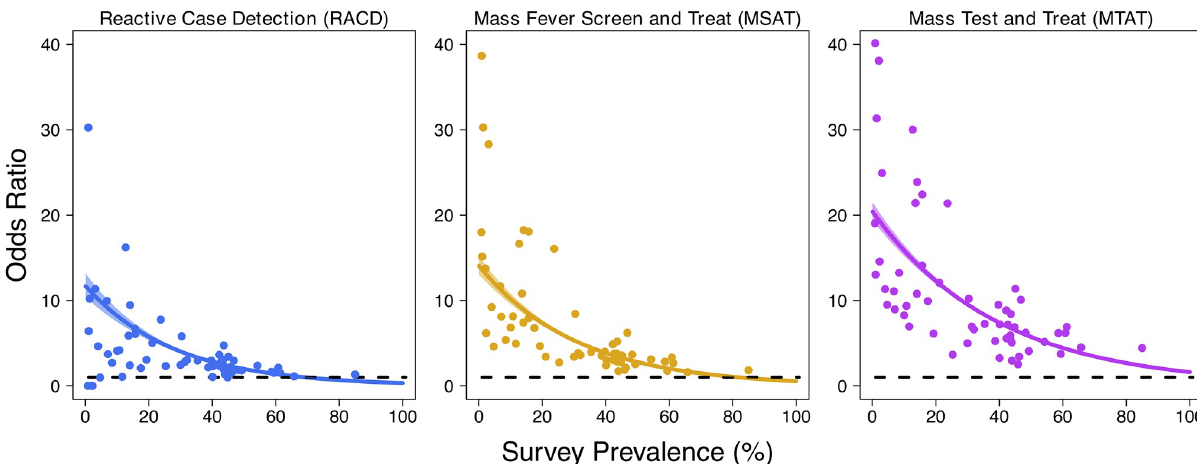
Fig 2. Malaria infection and the extent of household clustering according to detectability by different programmatic strategies. DHS data from 57 surveys and 23 countries detailing malaria infection status in children under 7 were collated, and the extent of infection clustering based on detectability by different programmatic strategies (RACD, MSAT or MTAT) was assessed. For each of these analyses, an individual was defined as residing in an index household if the household contained at least 1 other infection detectable through the programmatic strategy considered. The OR of being malaria positive in children who share a household with another child detectable through (A) RACD (clinical care seeking; population-level screening for infecton using routine diagnostics such as RDTs), (B) for the MSAT strategy (population-level recent fever screening), and (C) for the MTAT strategy (population-level screening for infecton using routine diagnostics such as RDTs) as compared to those who do not. Plots display the modelled OR (generated using a logistic-regression approach, coloured line) whilst points are the same ORs but calculated empirically for each survey. Pale shaded area represents the 95% CrI. CrI, credible interval; DHS, demographic health survey; MSAT, Mass Screen and Treat; MTAT, Mass Test and Treat; OR, odds ratio; RACD, Reactive Case Detection; RDT, rapid diagnostic